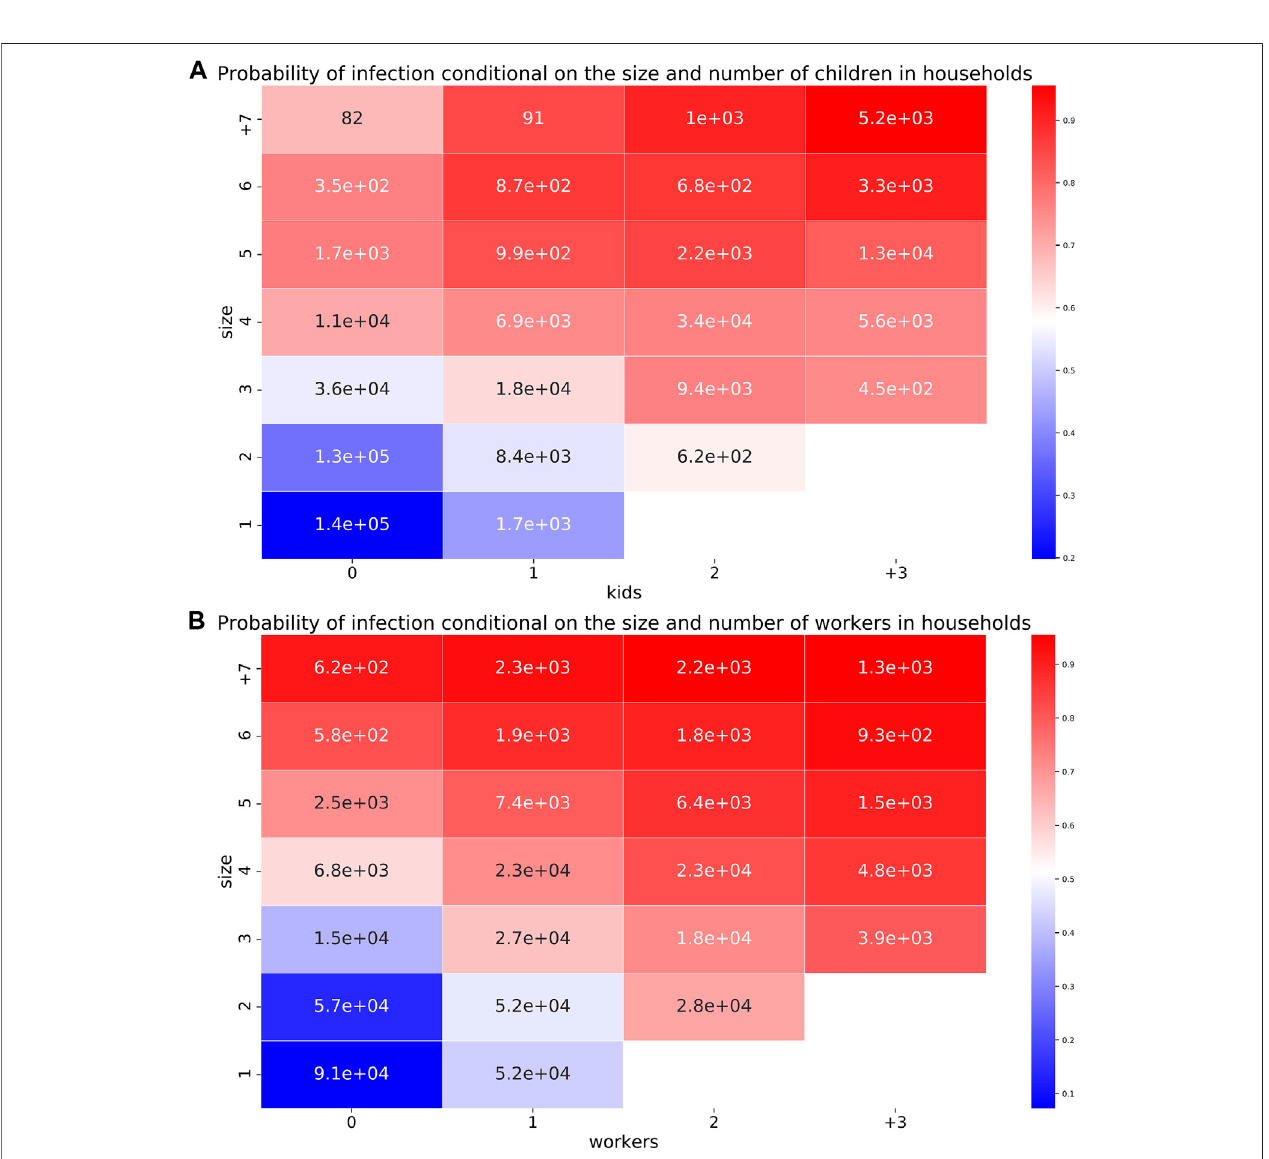
FIGURE 6 | Empirical infection probability in households, conditional on their size, number of children (A) , and workers (B) . The size of the population is displayed inside each cell.